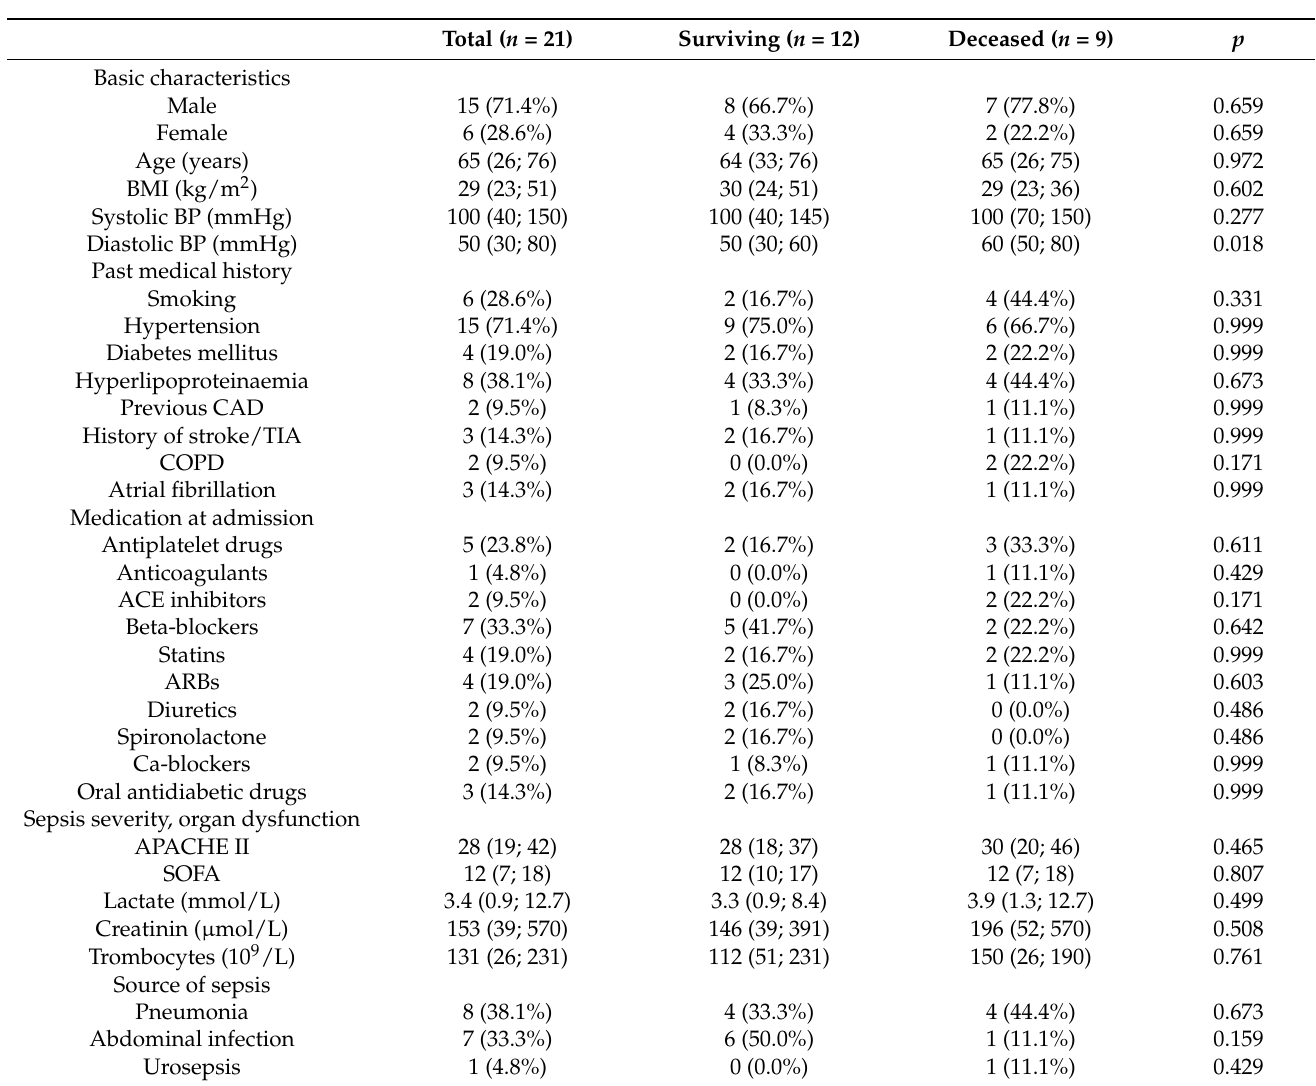
Table 1. Baseline characteristics of the study population, comparison of surviving and deceased septic shock